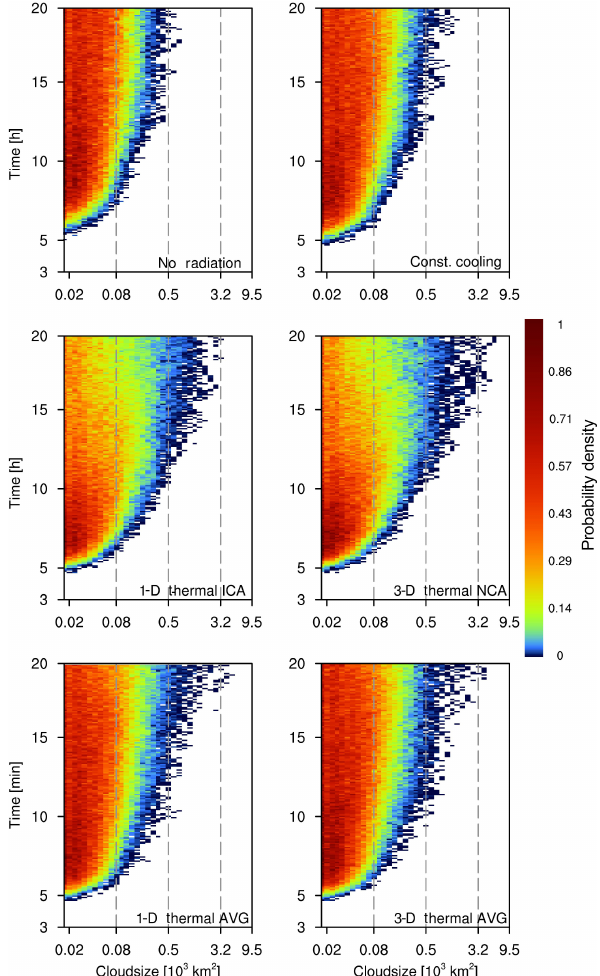
Figure 17. Probability density with respect to cloud size and the time of occurrence in the different simulations.